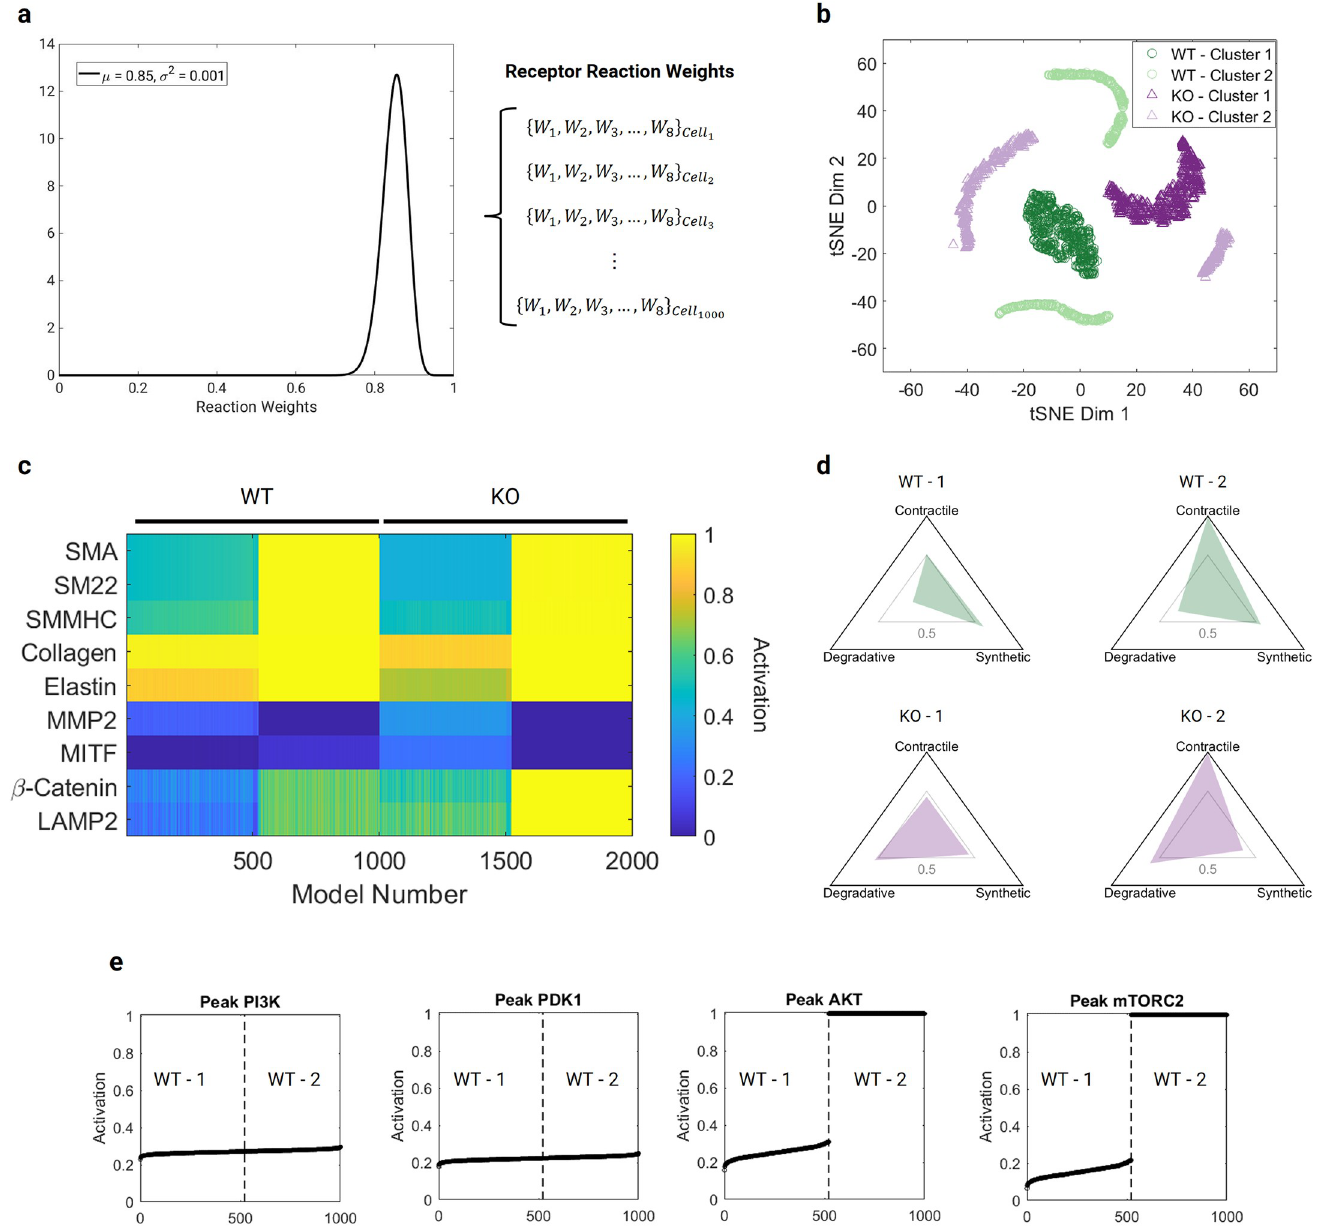
Fig 4. Cell population simulations. a) A beta distribution, with μ = 0.85 and σ 2 = 0.001, was used to randomly sample receptor reaction weights for 1000 different signaling network models for wild-type and KO cells. Each of the 7 receptor reactions in a distinct cell was assigned a different weight. b) Visualization of wild-type (circles) and KO (triangles) clusters using a t-distributed stochastic neighbor embedding (tSNE) algorithm. Two primary clusters for each condition were found using a density-based spatial clustering of applications with noise (DBSCAN) algorithm for the steady-state activation levels of network species. c) Heatmap showing the activation level of species relevant to contractile, synthetic, and degradative phenotypes for each of the 1000 models in each population (WT and KO). Clusters WT– 1 and KO– 1 are characterized by moderate-to-low activation of contractile proteins (SMA, SM22, SMMHC), while clusters WT– 2 and KO– 2 both have saturated levels of these species. d) The phenotypic characteristics of the average cell in each cluster was visualized in the contractile-synthetic-degradative phenotypic space. Both KO clusters are more degradative than the WT clusters, but clusters WT– 2 and KO– 2 retain their contractile capacity. e) The peak activation of species in the PI3K/AKT/mTORC2 positive feedback loop of WT models show that beyond a threshold (0.2716) of PI3K activation, the level of AKT and mTORC2 saturates, causing a bistable division into distinct clusters.